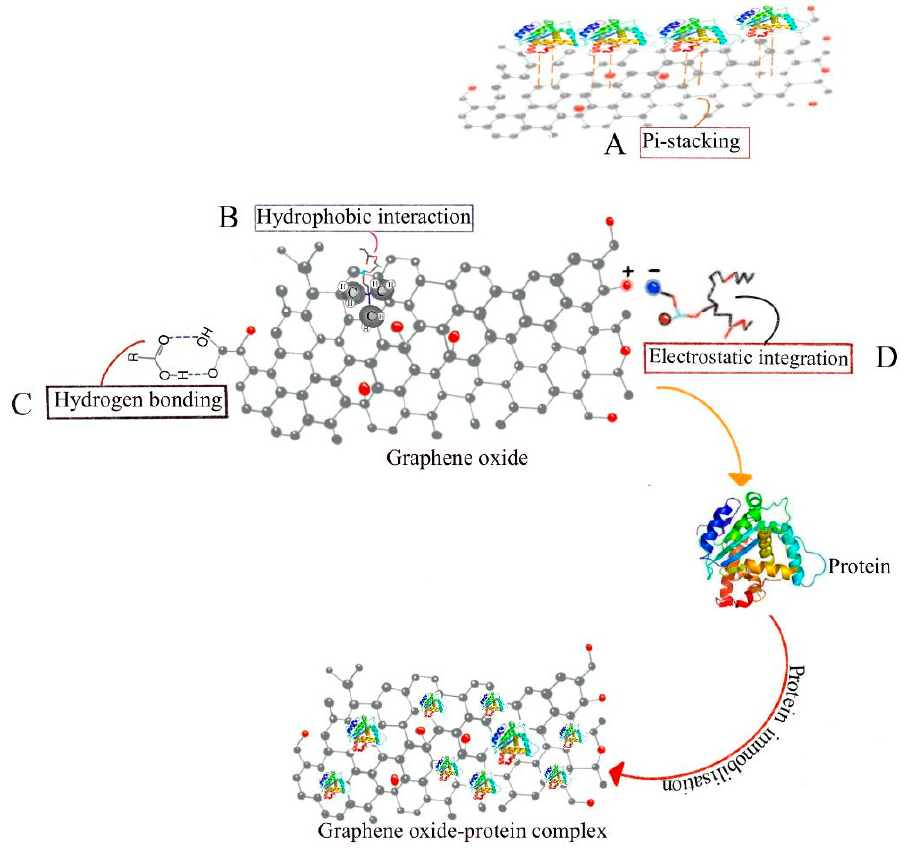
Figure 3. Illustrating different non-covalent bonds in protein binding. ( A ) Pi-stacking noncovalent interaction helps proteins bind to graphene oxide; ( B ) Hydrophobic interaction helps increase protein stability and bioactivity; ( C ) Hydrogen bonding stabilizes the protein structure; ( D ) Electrostatic integration is important in protein folding, stability, flexibility, and function.